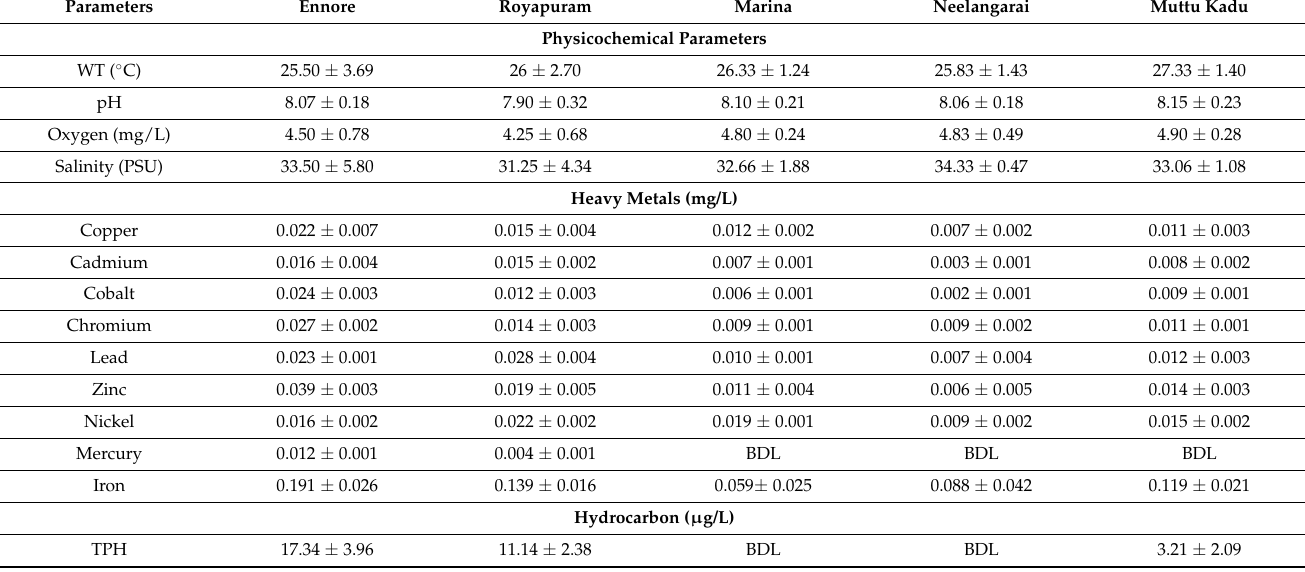
Table 1. Physicochemical parameters of the water samples collected from the East coast of